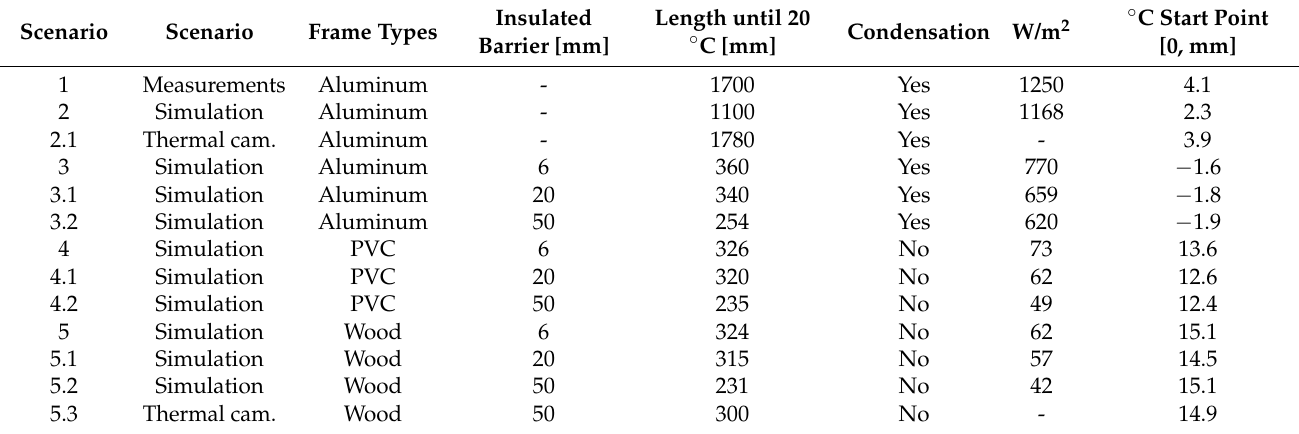
Table 2. Results and characteristics of the